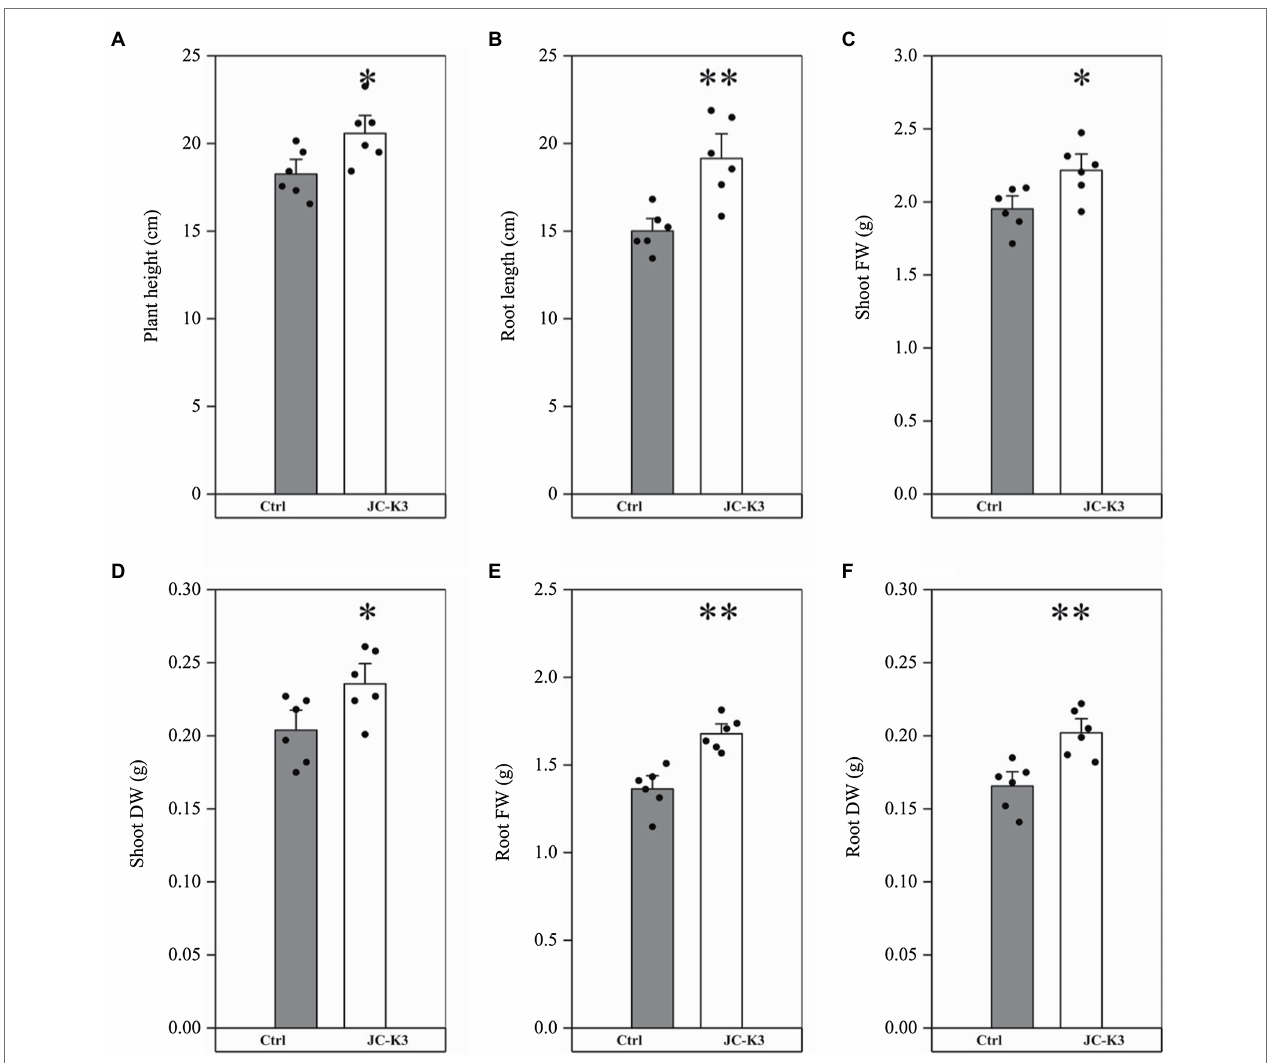
FIGURE 1 | Effect of inoculation of isolate JC-K3 on plant growth and biomass content; (A) Plant height, (B) Root length, (C) Shoot fresh weight, (D) Shoot dry weight, (E) Root fresh weight, and (F) Root dry weight. Each value is the average of six replicates. The error bar represents the SE, the average of six replicates. * on the bar chart of each treatment indicates the significant difference between the control group and the treatment group, * p < 0.05; ** p < 0.01 (Student’s t -test). The black and white columns represent the control (Ctrl) and JC-K3 inoculated plants,